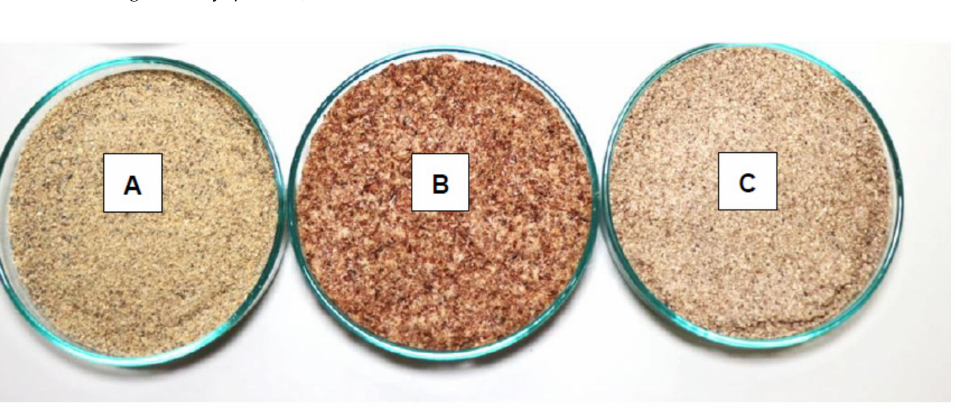
Figure 1. Ground edible insect flour of three different species. ( A ) G. belina ; ( B ) M. subhylanus ; and ( C ) H. illucens